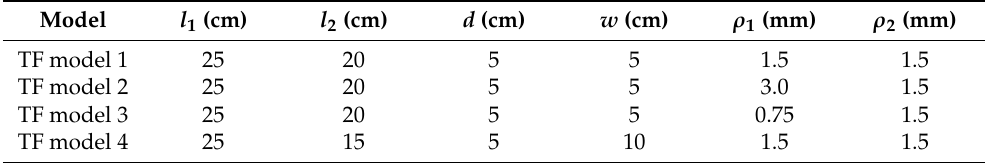
Table 2. Dimensions of the two-fold (TF)